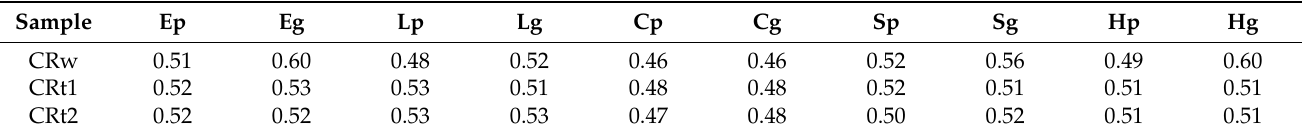
Table 4. Mean CR values of samples after water immersion, before thermocycling (w), after thermo- cycling for 5000 cycles (t1) and after thermocycling for 10,000 cycles (t2).